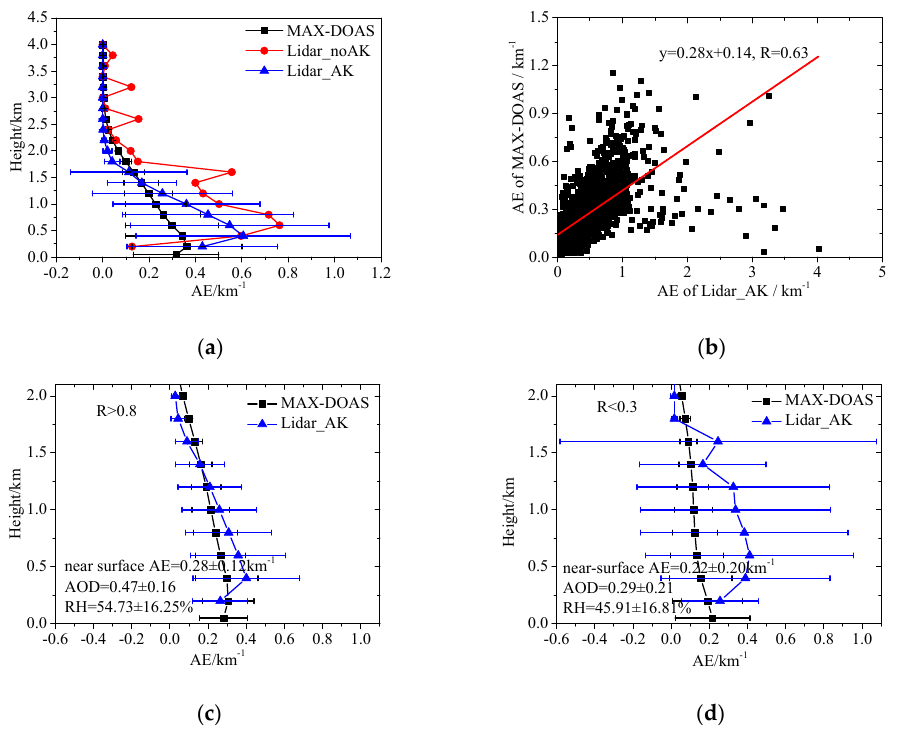
Figure 7. Vertical profiles of aerosol extinction (AE) during the whole observation period. ( a ) The black curve with squares denotes the average profile based on all the qualified MAX-DOAS results. Correspondingly, the curves with red dots (blue triangles) present the lidar results at the same time without (with) MAX-DOAS averaging kernel (AK) weighting. ( b ) The correlation between MAX-DOAS and lidar_AK for all the hourly AE profiles below 2.5 km altitude. The red line denotes the linear regression. Also shown is the linear equation and correlation coefficient (R). ( c ) AE profiles separately averaged from hourly MAX-DOAS and lidar_AK data when their correlation coefficients are larger than 0.8. The equations present the corresponding mean values ± standard deviations of MAX-DOAS AOD, near surface AE, and RH. ( d ) As ( c ), but for R < 0.3. The error bars for MAX-DOAS and lidar_AK in panels a,c,d denote the standard deviations. Lidar vertical profiles of AE with vertical resolution of 15 m are interpolated into MAX-DOAS retrieval height.